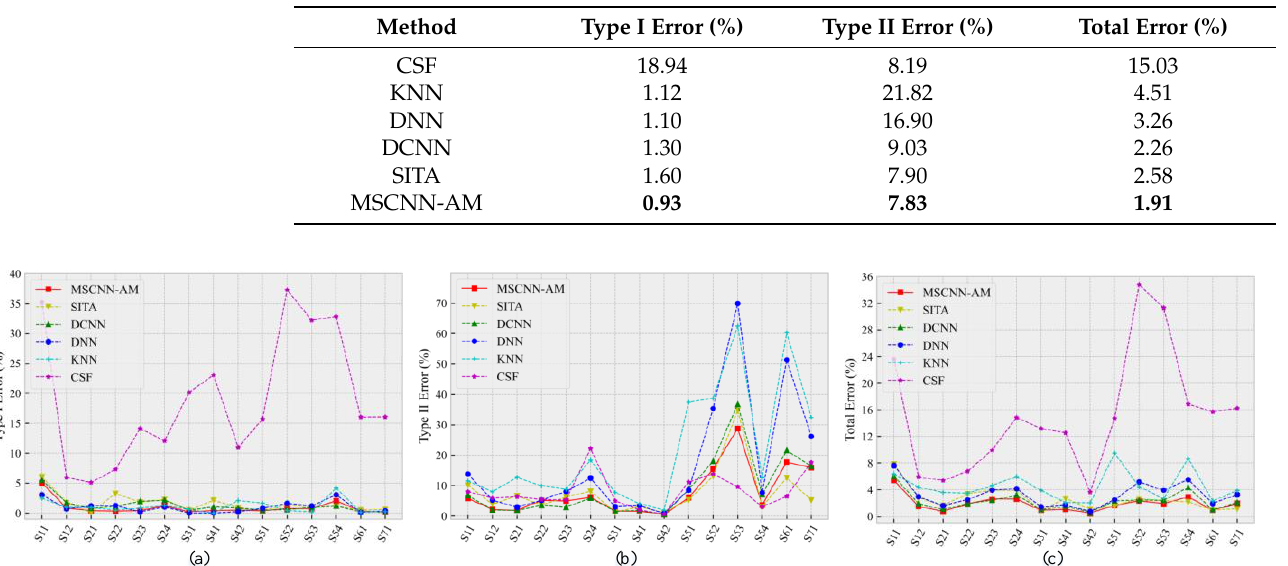
Table 4. Comparison of the filtering performance of six different filtering methods upon the IS- PRS dataset.